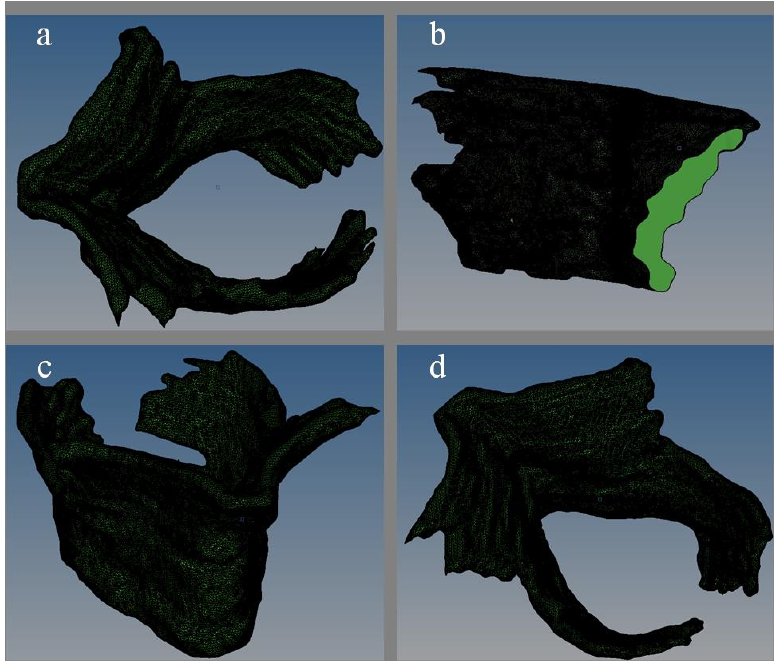
Figure 1. The three-dimensional solid diagram of pelvic floor muscle (( a ) plan view; ( b ) side view; ( c ) lateral elevation; ( d ) side plan view).